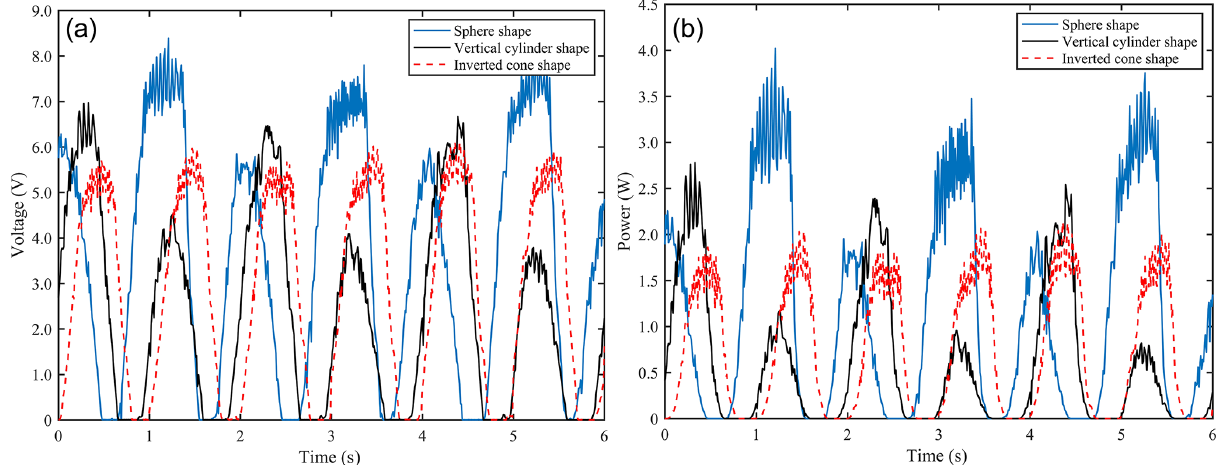
Figure 11. Energy efficiency characteristic curves of various axisymmetric floating bodies. (a) Voltage curve. (b) Power curve.